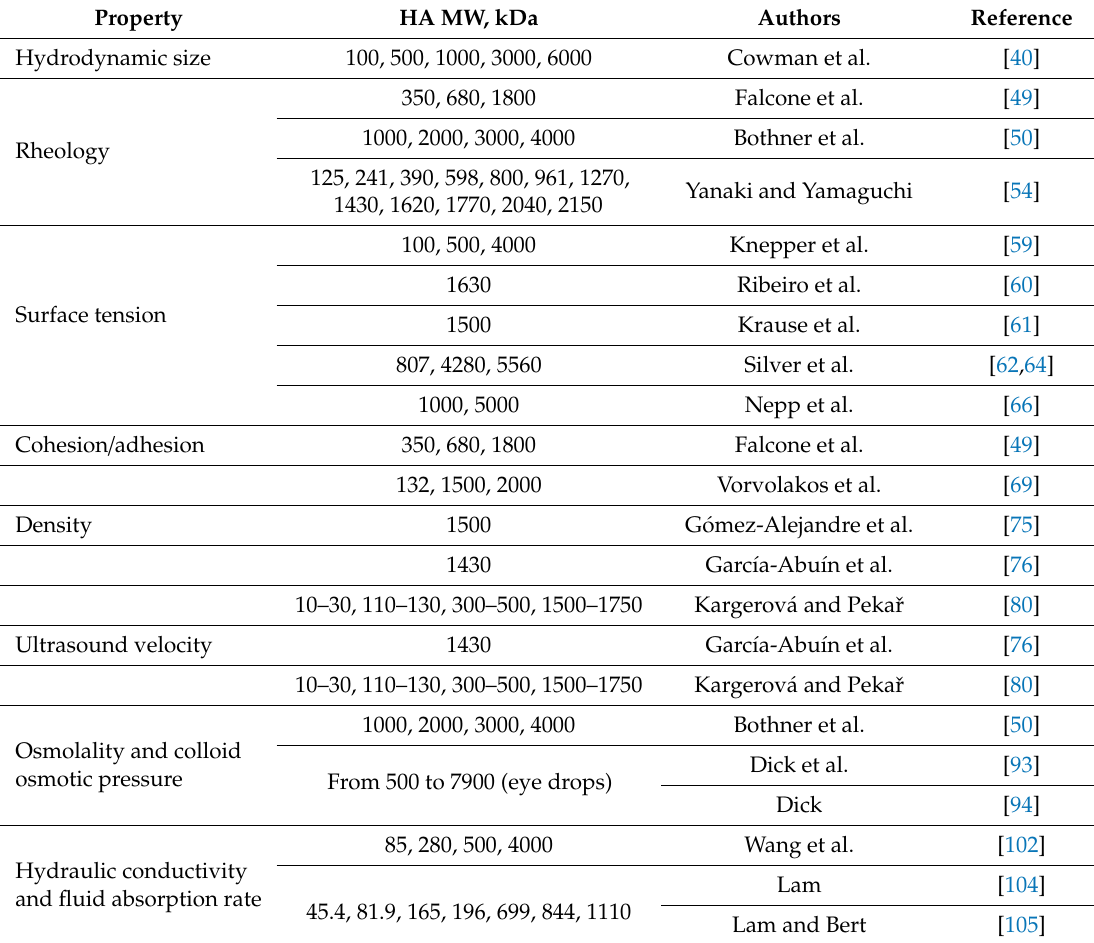
Table 5. Summary of structural, physical, and physico-chemical properties of hyaluronic acid with various molecular